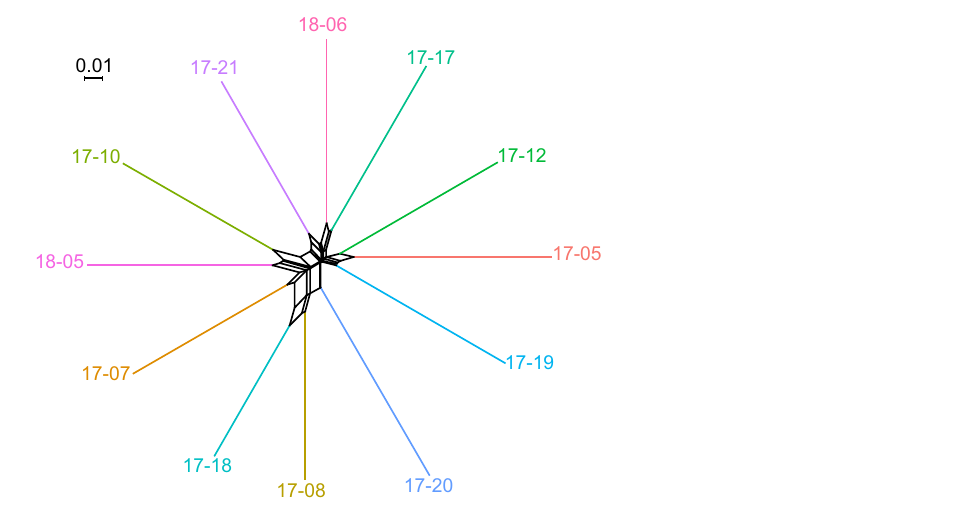
Figure 3. Phylogenetic network based on genomic diversity data for 12 bowhead whales from the EGSB stock indicating a star-like (branching-from-the-centre) pattern, but no structuring of more closely related